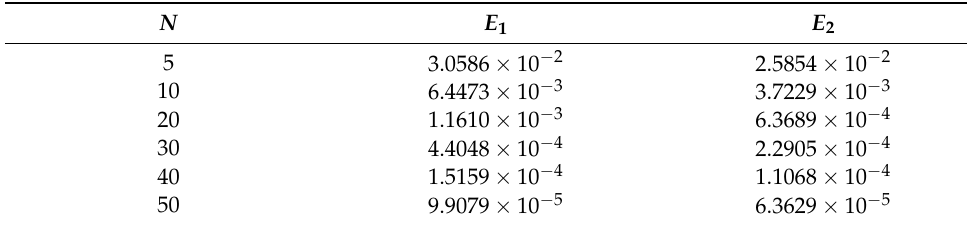
Table 3. Computed relative error estimations for Example 2 from some values of N .